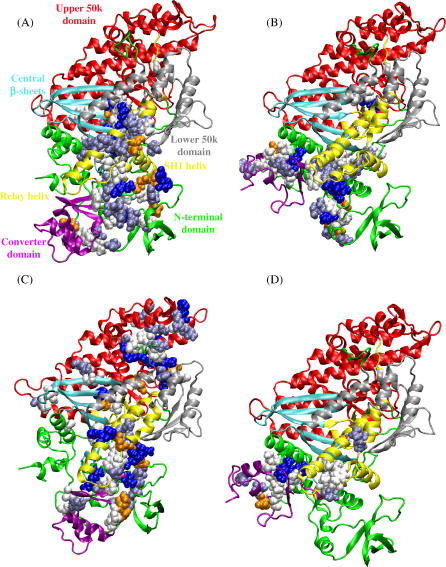
The Hinge Residues (Shown in the van der Waals Form) Identified by DynDom [84,85] Based on Results of Normal Mode AnalysisSee Table 2 and in Protocol S1 Tables B1–B4 and B6.Upper 50-kD domain, lower 50-kD domain, converter domain, and central β sheet are shown in red, silver, purple, and cyan, respectively. Strut loop, relay helix, P-loop, Switch I and Switch II, and SH1 helix are shown in yellow. The rest of the protein is shown in green. The hinge residues are colored based on residue type—blue, basic; orange, acidic; slate blue, polar; white, nonpolar. The four figures are based on modes with large involvement coefficients for different transitions: (A) 1FMW → 1VOM, (B) 1VOM → 1Q5G, (C) 1Q5G → 1FMW, (D) 1VOM → 1FMW.